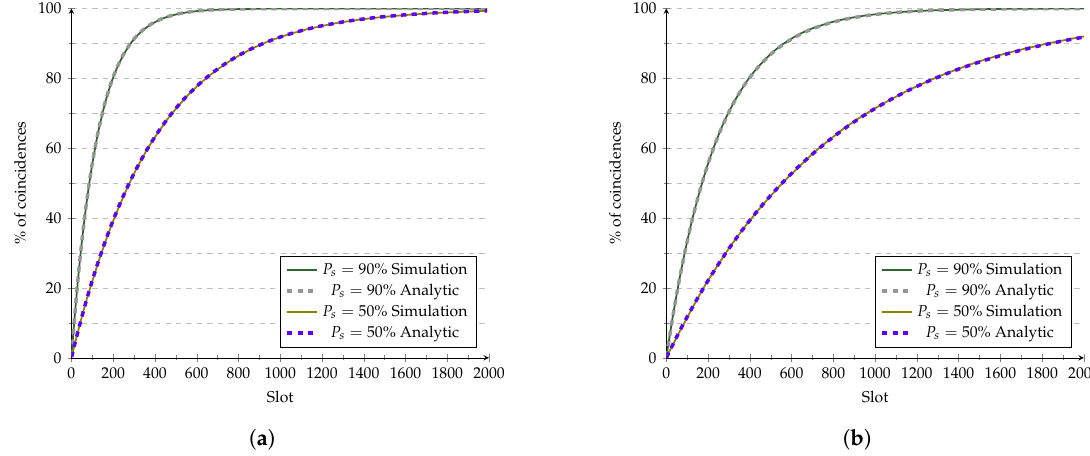
Figure 15. Evaluation of ( a ) Random’s and ( b ) Birthday’s analytic models vs. simulations at 10% duty